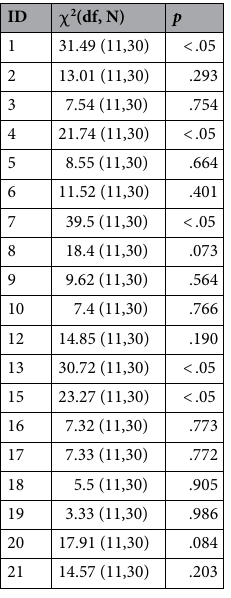
Table 1. Chi-square test parameters by participant.